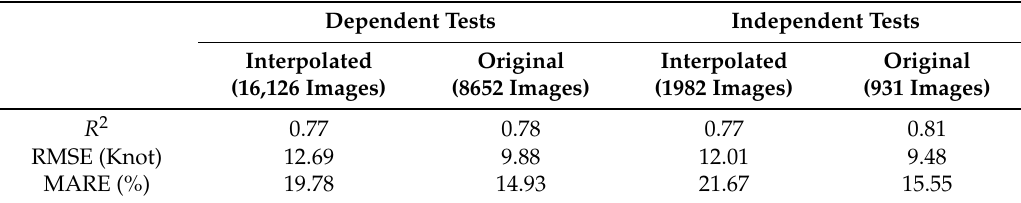
Table 6. Comparison of the regressed model between using the original and interpolated best-track intensities.